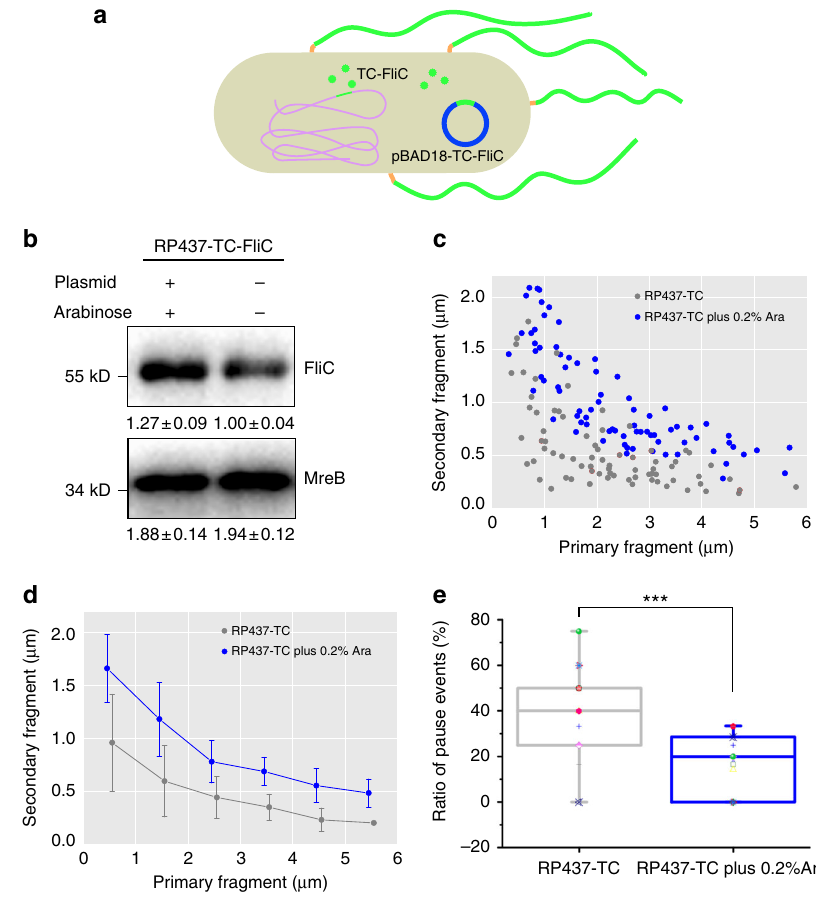
Fig. 5 Pauses in fl agellar growth can be partially recovered by overexpression of FliC. a Schematic of fl agellin overexpression strategy for the RP437-TC- FliC strain carrying plasmid pBAD18-TC-FliC. b Top: Immunoblotting of total fl agellin (FliC) of RP437-TC-FliC strains with or without expression of a plasmid-borne RP437-TC-FliC gene. Bottom: Detection of cytoskeleton protein MreB was used as a loading control. The bands were quantitated by ImageJ (relative fl agellin levels report Mean ± S.D., n = 3). Mann-Whitney test was performed de fi ning differences as signi fi cant, ** P < 0.05. Full blots are shown in Supplementary Fig. 9a. c Scatter plot of the lengths of secondary versus the primary segments from which they grew for 30 min by SIM double-color imaging (For two cultures, RP437-TC-FliC strains with or without plasmid expression, 75 and 77 fl agella were analyzed respectively.). d Average length of the secondary segments during 30 min for the two cultures in c , binned at a 1- µ m interval. Error bars are standard deviation. e The comparison of fl agellar growth between two cultures (RP437-TC-FliC strains with or without plasmid expression) performed by real time imaging of single fl agellar growth. Flagellar growth rate slower than 5 nm/min between two frames in a 10-min interval is designated one pause event. *** P < 0.01. The number of fl agella analyzed per group was 13 and 14,